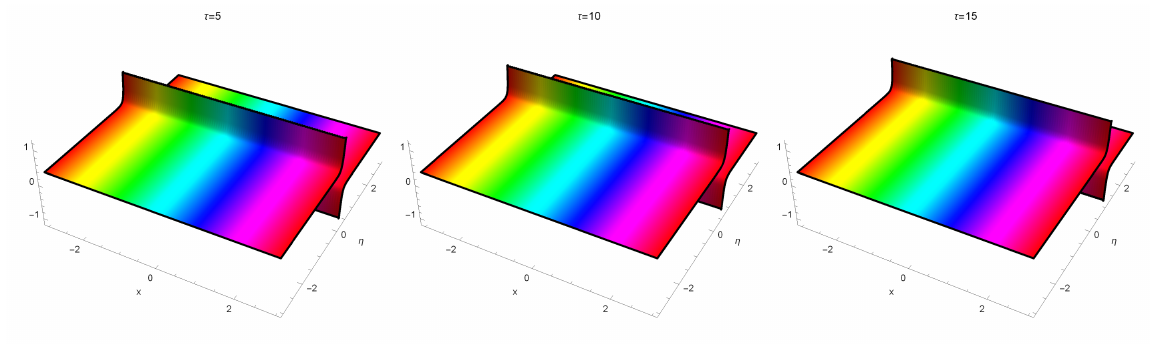
Fig. 7. The solution w 9 ( x , y , t ) for σ = 3.3, µ 1 = 0.01, µ 2 = 0.35, µ 3 = 0.2, α 0 = 0.5, β 1 =